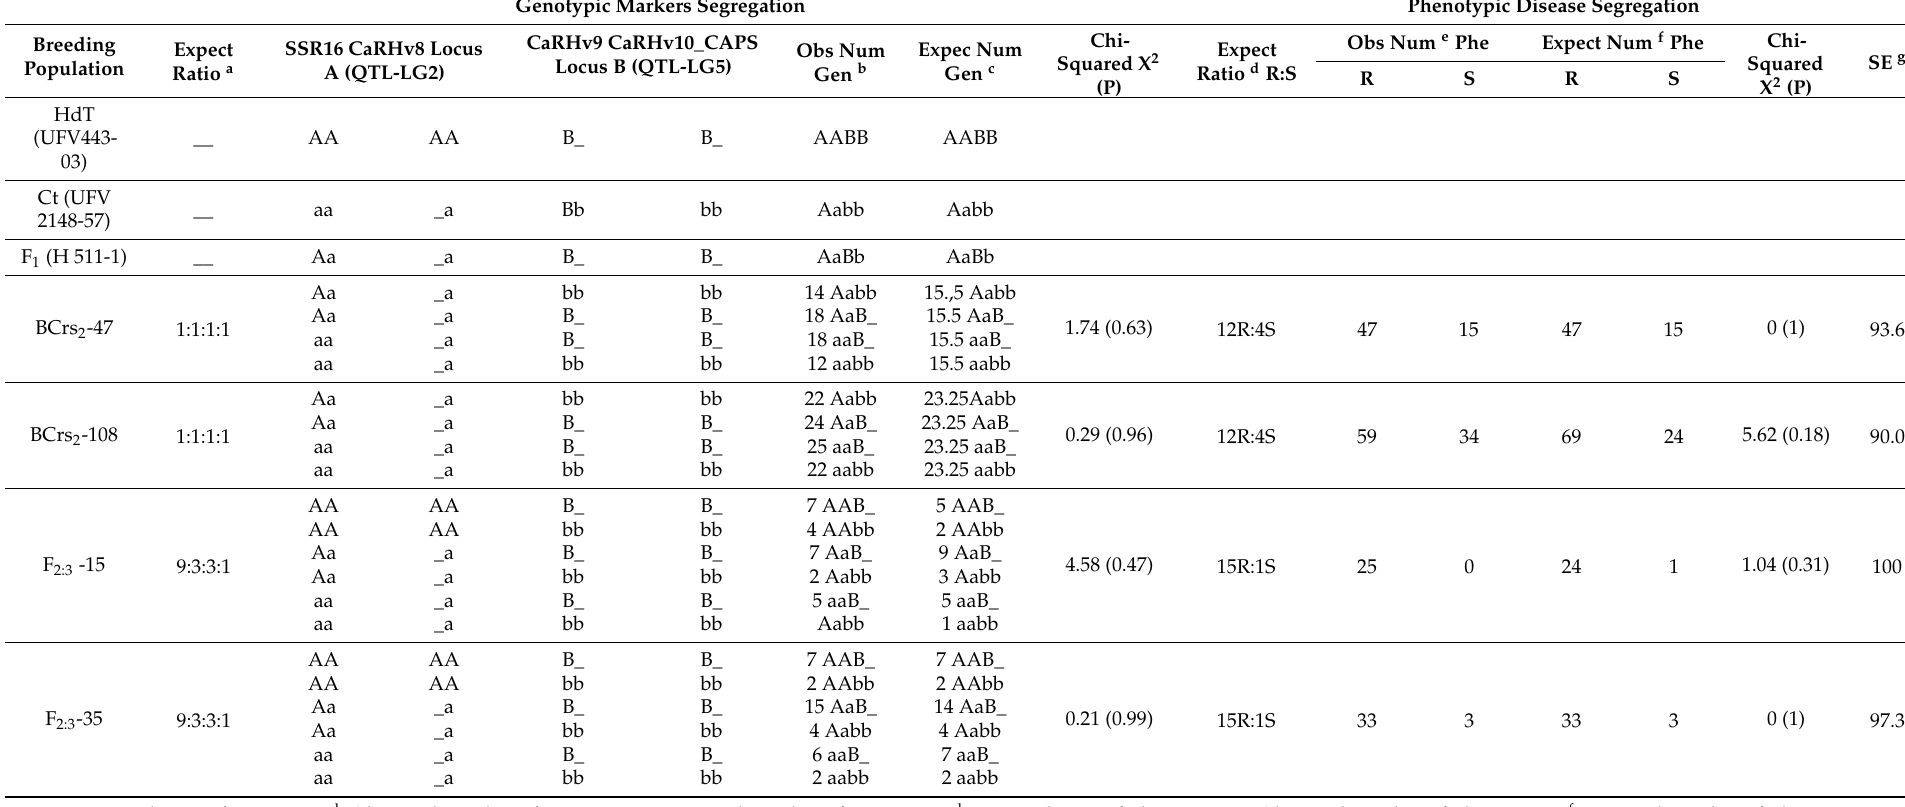
Table 2. Expected genotypes of coffee and segregation analyses for rust resistance in the BCrs 2 and F 2:3 populations. Genotypic Markers Segregation Phenotypic Disease